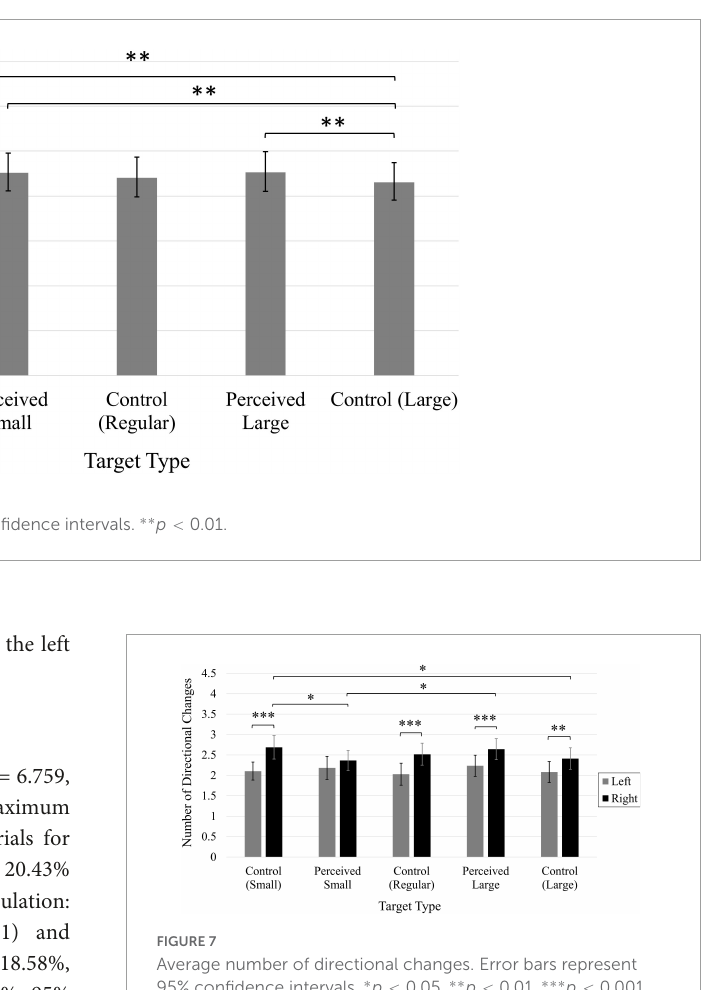
FIGURE7 Average number of directional changes. Error bars represent 95% confidence intervals. ∗ p < 0.05, ∗∗ p < 0.01, ∗∗∗ p <